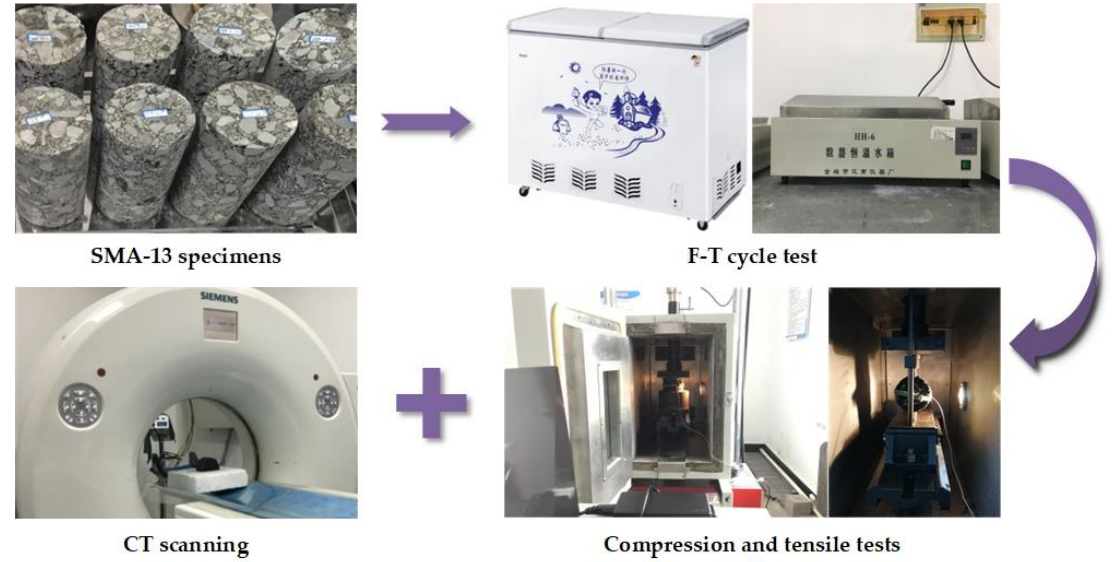
Figure 1. The research framework of this study.